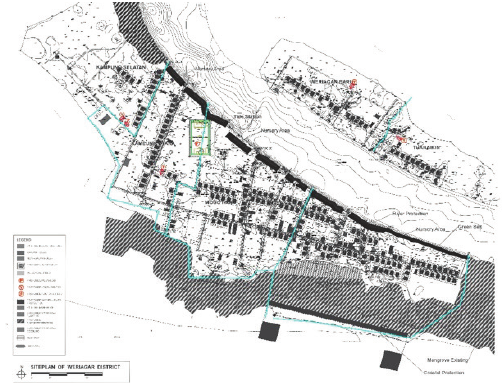
Figure 4. Arrangement pattern of house